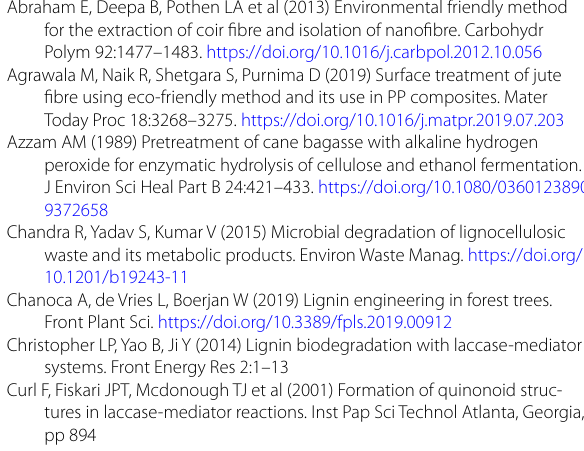
GO nanocellulose and (c) laccase +